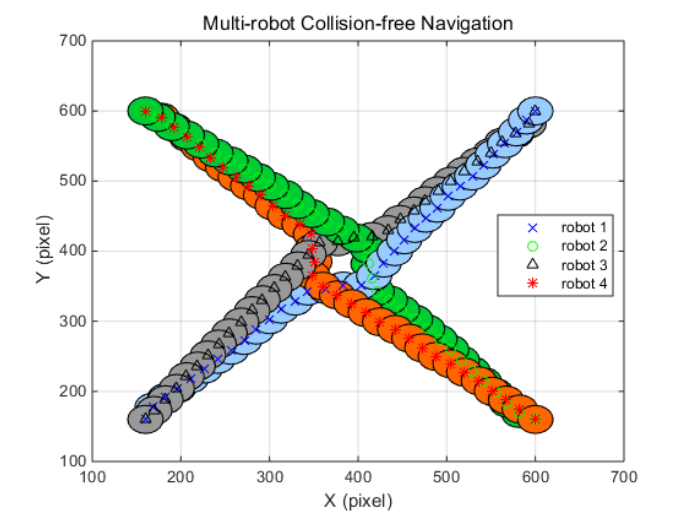
Figure 8. FAHP–cooperative game theory (CGT) algorithm for four-robot navigation.